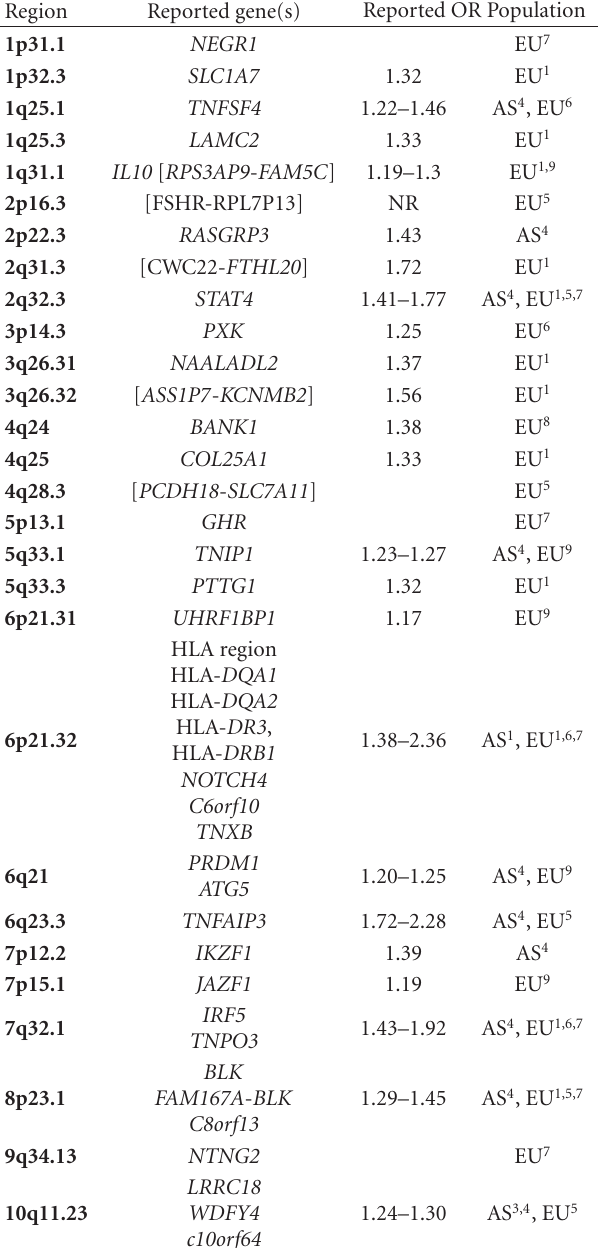
Table 1: Loci associated with SLE from GWAS. Table adapted from http://www.genome.gov/gwastudies/. A number of these genes were associated with SLE prior to GWAS and have now been replicated, while others await replication. Intergenic regions are listed in brack- ets. It is important to note that many genes associated with SLE in individuals of European ancestry are not associated with the disease in Asian populations, with the converse also holding true. Similar di ff erences in susceptibility are certain to be found between other populations for whom the requisite GWAS have not yet been con- ducted. As Bustamante et al. [3] and others have pointed out, indivi- duals of European ancestry are heavily overrepresented in GWAS, and many more comparison studies are needed to address this sam- pling